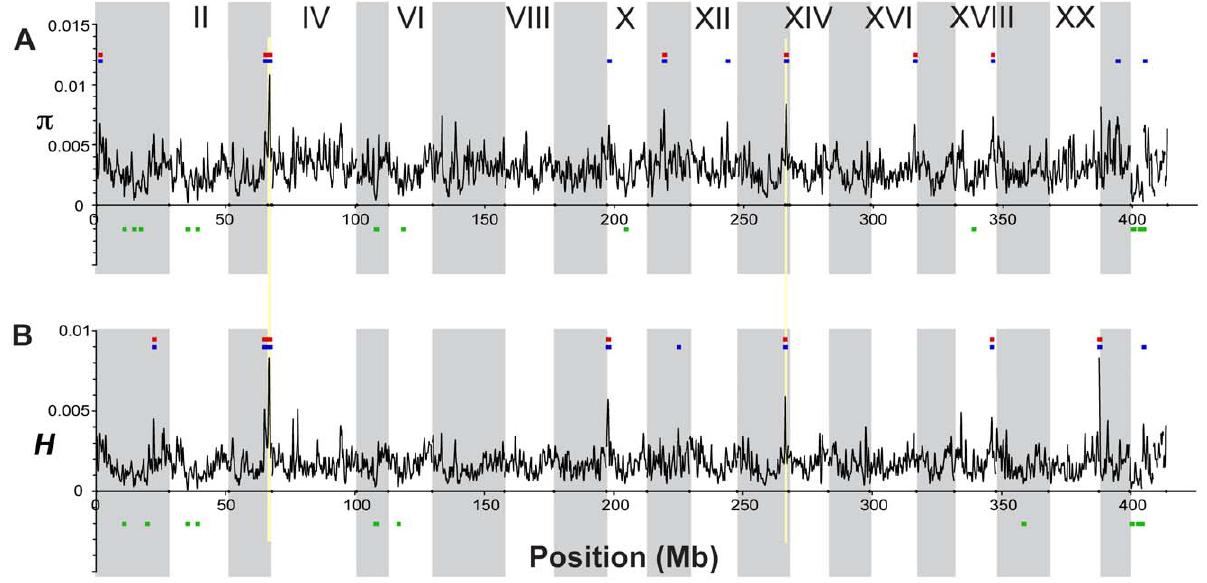
Figure 4. Genome-wide patterns of nucleotide diversity. Each plot shows a smoothed distribution of the statistical measure across the genome (black lines). Colored bars above and below the distributions indicate regions of significantly elevated (p # 10 2 5 , blue; p # 10 2 7 , red) and reduced (p # 10 2 5 , green) values, assessed by bootstrap resampling. Vertical shading indicates the 21 linkage groups and the unassembled scaffolds greater than 1 Mb in length, and gold shading indicates two regions showing evidence of balancing selection as discussed in the text. (A) Nucleotide